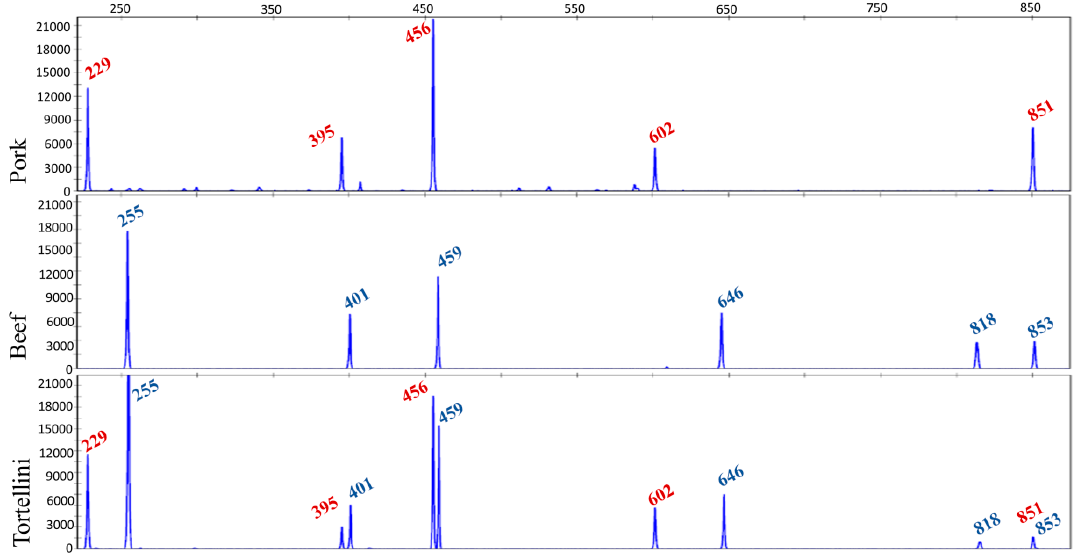
9 of 17 Figure 2. Feed sample analysis. The capillary electrophoresis (CE)-TBP profile gained from one cattle feed sample. The peak size (base pairs) is reported on the x axis and the fluorescence intensity (RFU, relative fluorescence unit) on the y axis. Green labels indicate specific peaks generated by DNA amplification of declared ingredients (sunflower, wheat, maize and soy), red labels indicate amplicons originated from detected undeclared species (flax and rice in gray boxes). Since the newly developed vertebrate primers give no amplification products in any plant assay, their use to exclude the presence of fish flour in animal feed is possible, although not tested, yet. 5.3. Meat and Fish Food Authentication TBP-assisted genomic profiling of the most common meat species used in food manufacturing and a couple of possible contaminants (mouse and human) revealed that identification at the species level can be straightforward with the use of a primer pair capable of amplifying the third beta-tubulin intron commonly shared among vertebrates. By contrast with what often observed in plants, intraspecific TBP-dependent polymorphism is almost absent in mammals (different bovine and goat breeds tested), while a few allelic variants were detected in chicken, with any obvious consequence